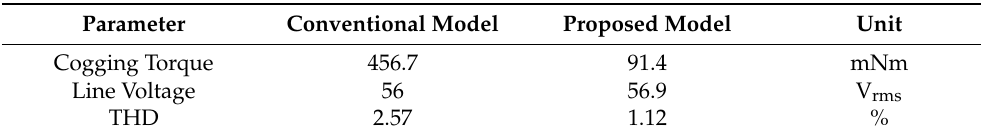
Table 2. Comparison of no − load performance of the conventional spoke − type model and the proposed model.